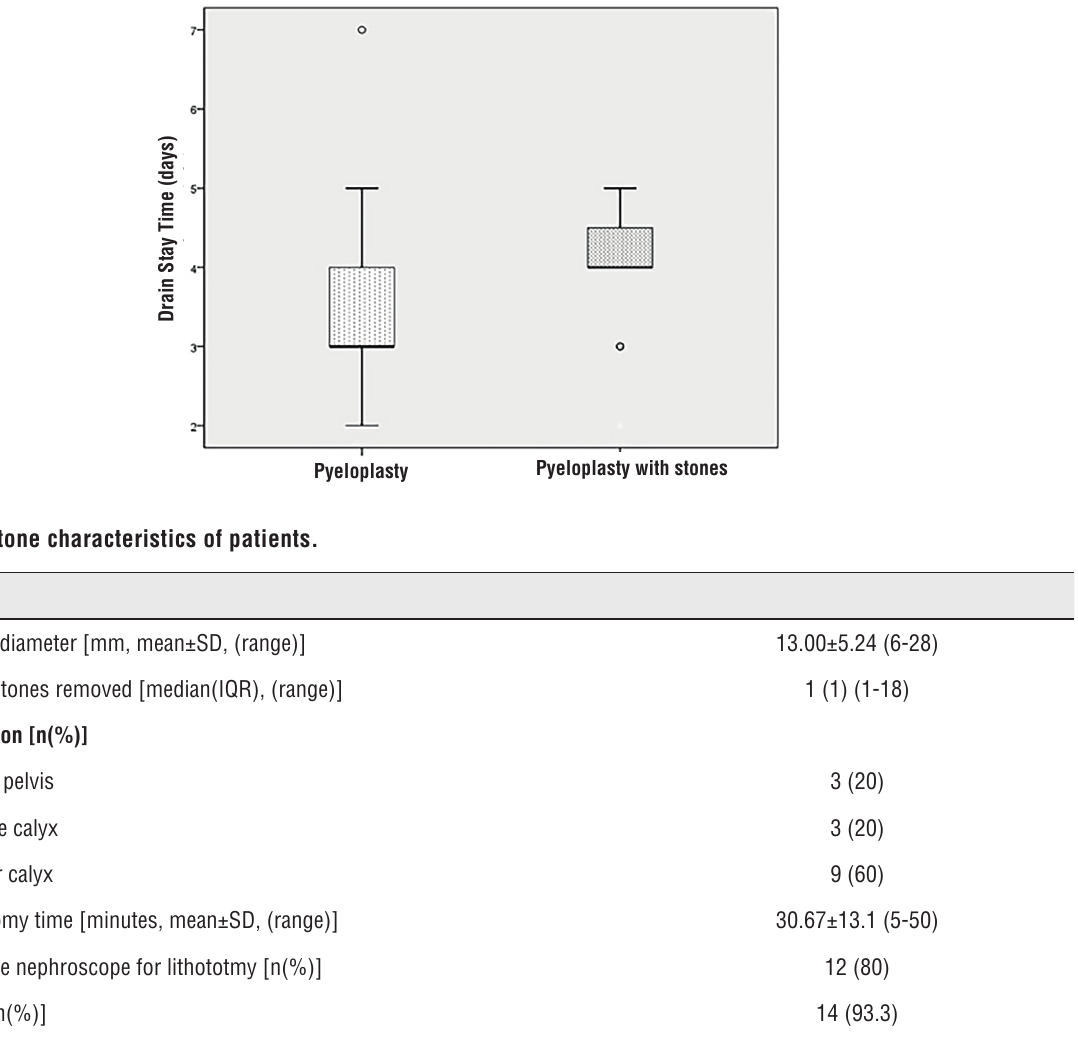
Figure 2 - Distribution of time to remove drain between laparoscopic pyeloplasty and laparoscopic pyeloplasty with pyelolithotomy.